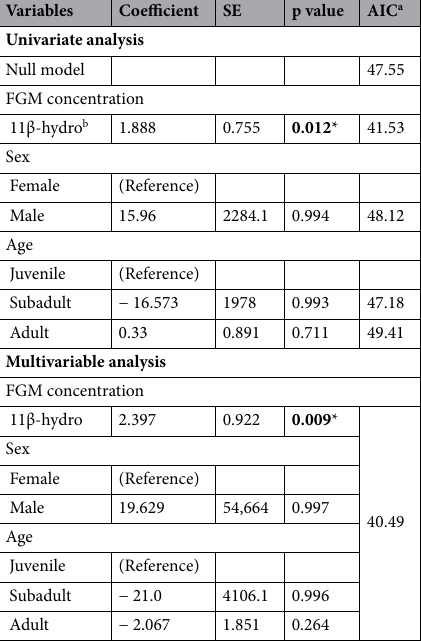
Table 5. Explanatory variable statistics and AIC values of each variable tested alone and the full model in the logistic regression analysis by using Formosan macaque with and without symmetrical alopecia as